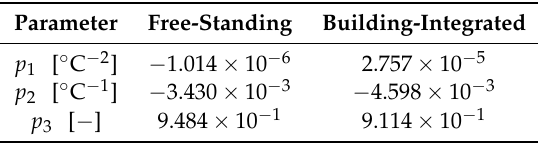
Figure 5. ( a ) Temperature and low-irradiance efficiency ( η temp ) as a function of the average daily ambient temperature ( T 24 ) for the given locations: best-fitted models of Equation (3) (lines) are compared with the values taken from the PVGIS tool (dots) for the 80 locations in Europe and Africa shown in Figure 3. Crystalline silicon solar cells are considered. Free-standing (FS) installations are depicted in blue; whereas, building-integrated (BI) installations in red. ( b ) Reflectance efficiency ( η refl ) as a function of the latitude φ for the 80 locations in Europe and Africa: the values taken from the PVGIS tool (dots) and their average value (line) are shown. Table 2. Coefficients of the model for the temperature efficiency in Equation (3) fitted over the 80 considered locations in Europe and Africa (see Figure 3). The reported values refer to crystalline silicon solar cells in either free-standing or building-integrated